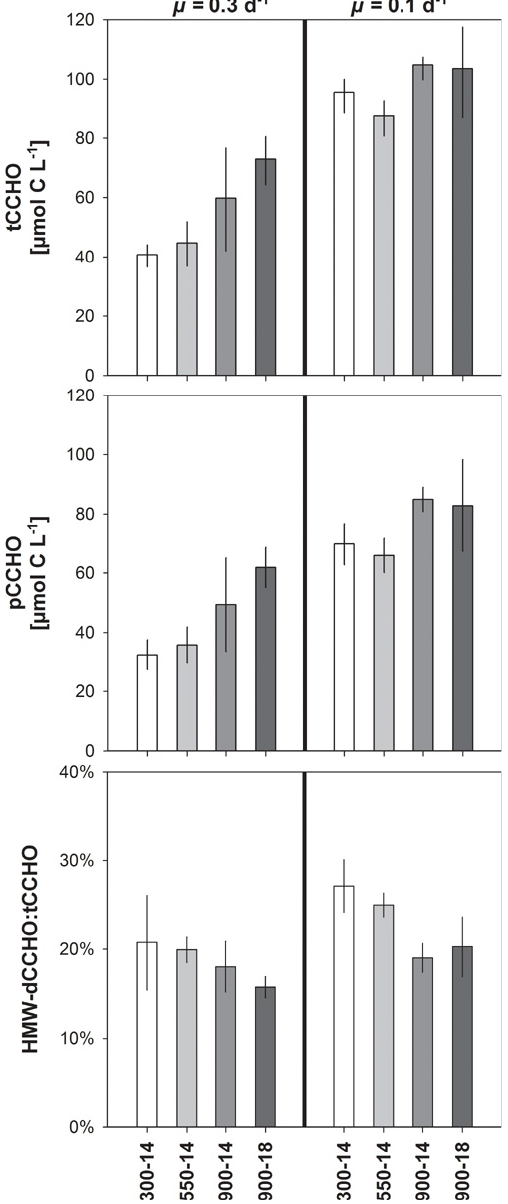
Fig. 2. Total combined carbohydrates (tCCHO, upper panel), par- ticulate CCHO (pCCHO, middle panel) and contribution (mol % C) of high molecular weight ( > 1kDa) dissolved CCHO (HMW- dCCHO) to tCCHO (lower panel) at various growth-, CO 2 and tem- perature conditions. Mean values and standard deviations were de- rived from sampling 1, 2 and 3 ( µ = 0 . 3d − 1 ) and sampling 4, 5 and 6 ( µ = 0 . 1d − 1 ) ,